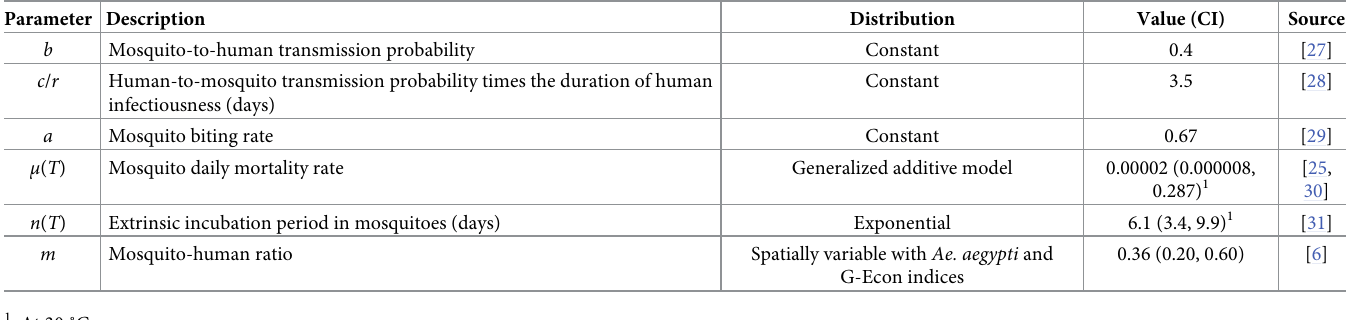
Table 1. Parameters used to create prior R 0 estimates from the